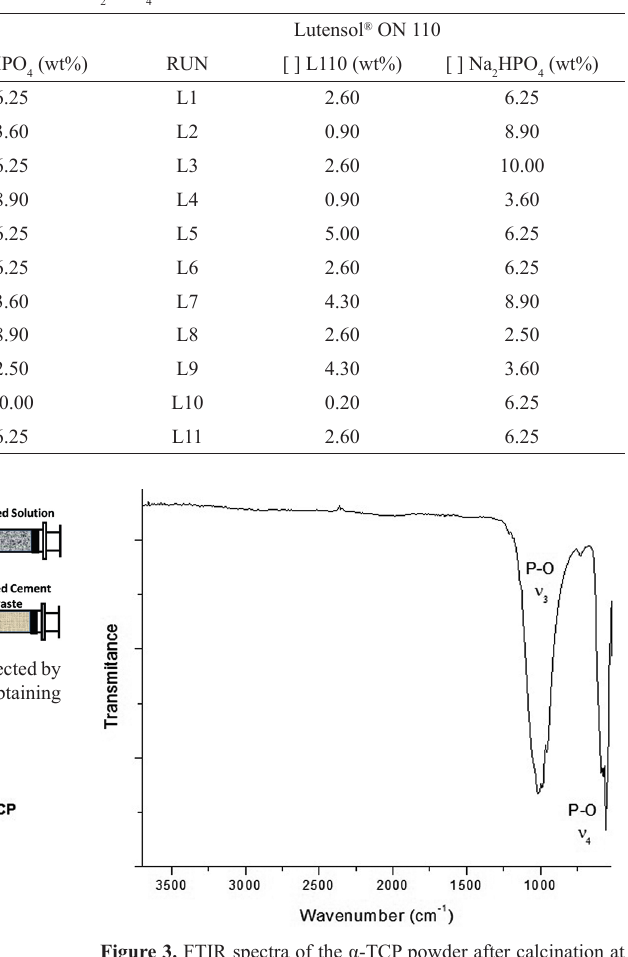
Table 2: Experimental combinations of different concentrations of Na